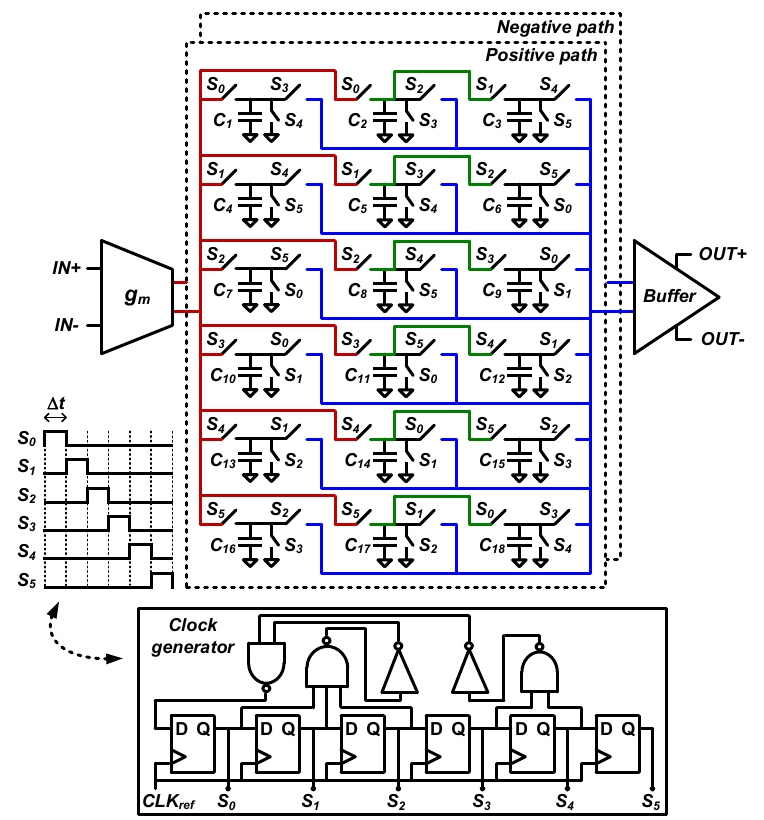
Figure 3. Proposed architecture and its clock generation. Red lines indicate charge sampling paths, blue lines indicate read ‐ out paths, and green lines indicate charge redistribution paths.